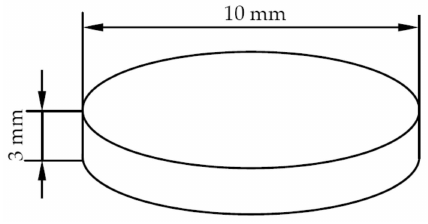
Figure 1. The proton irradiation sample